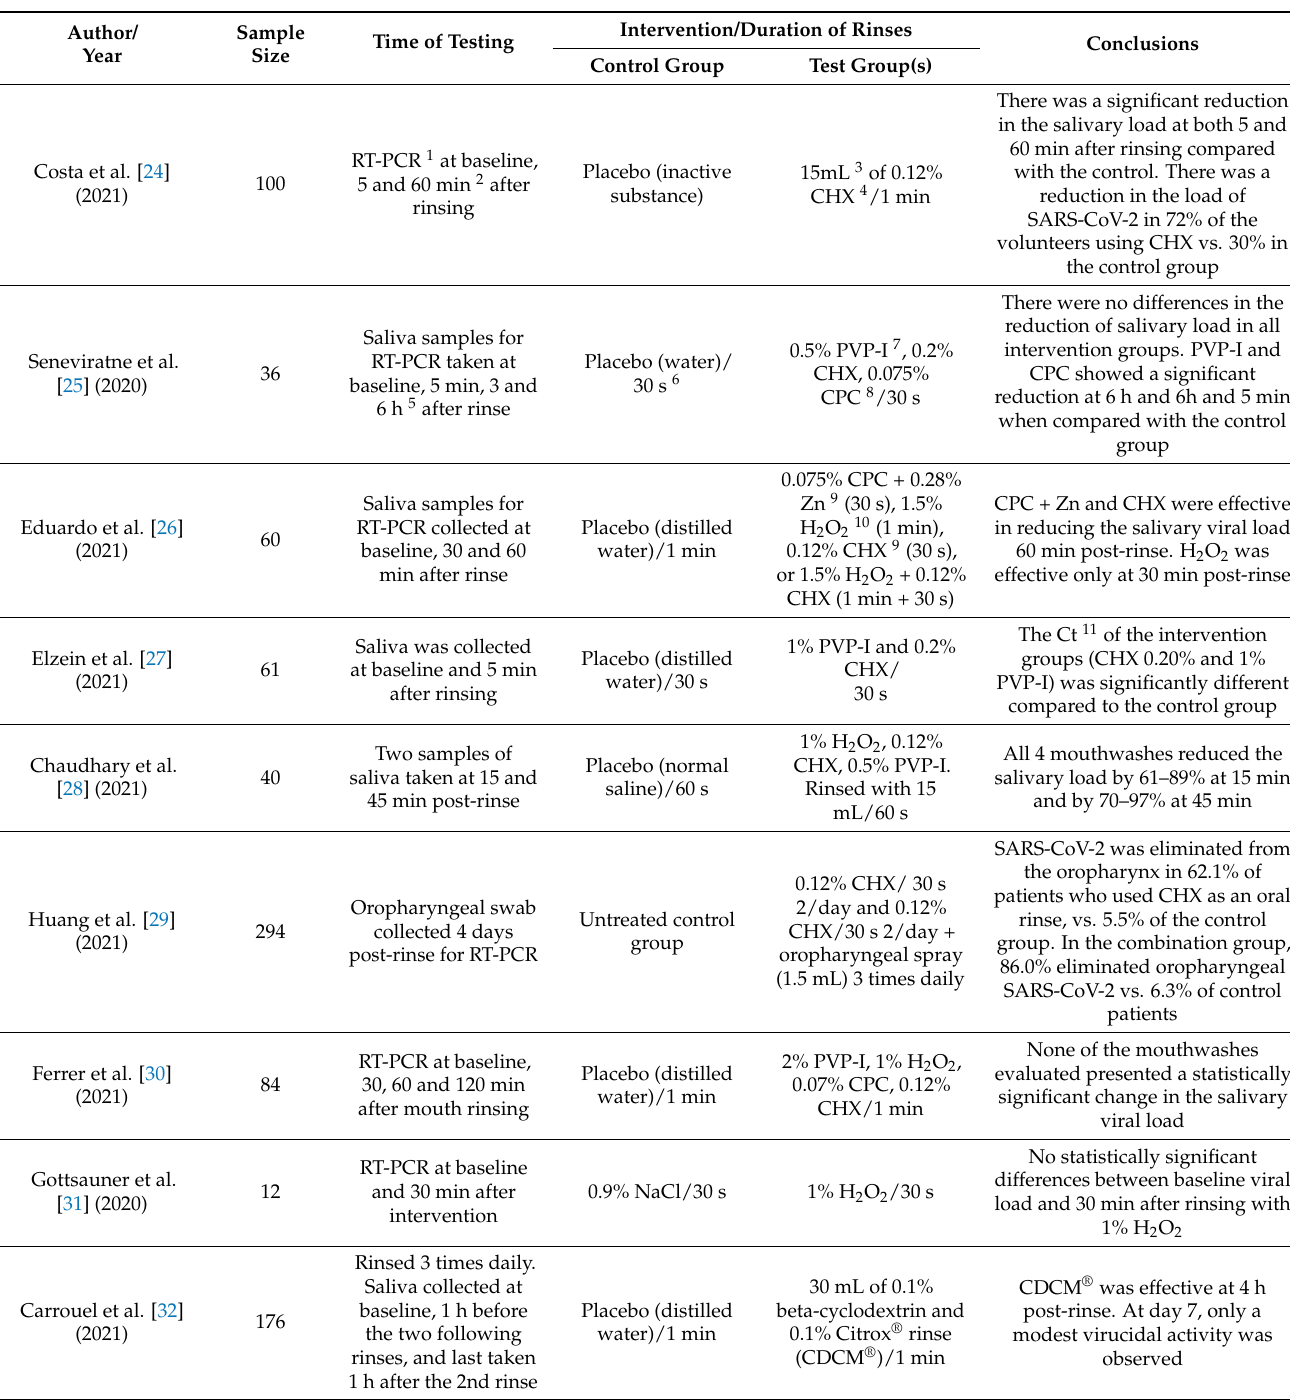
Table 2. Summary of the clinical trials